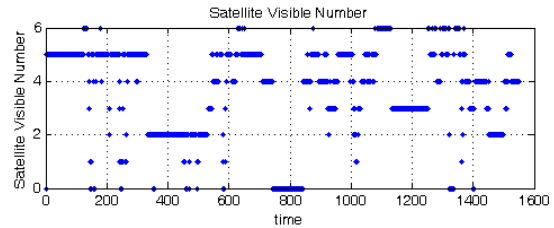
Figure 12. Satellite visible number in the practical